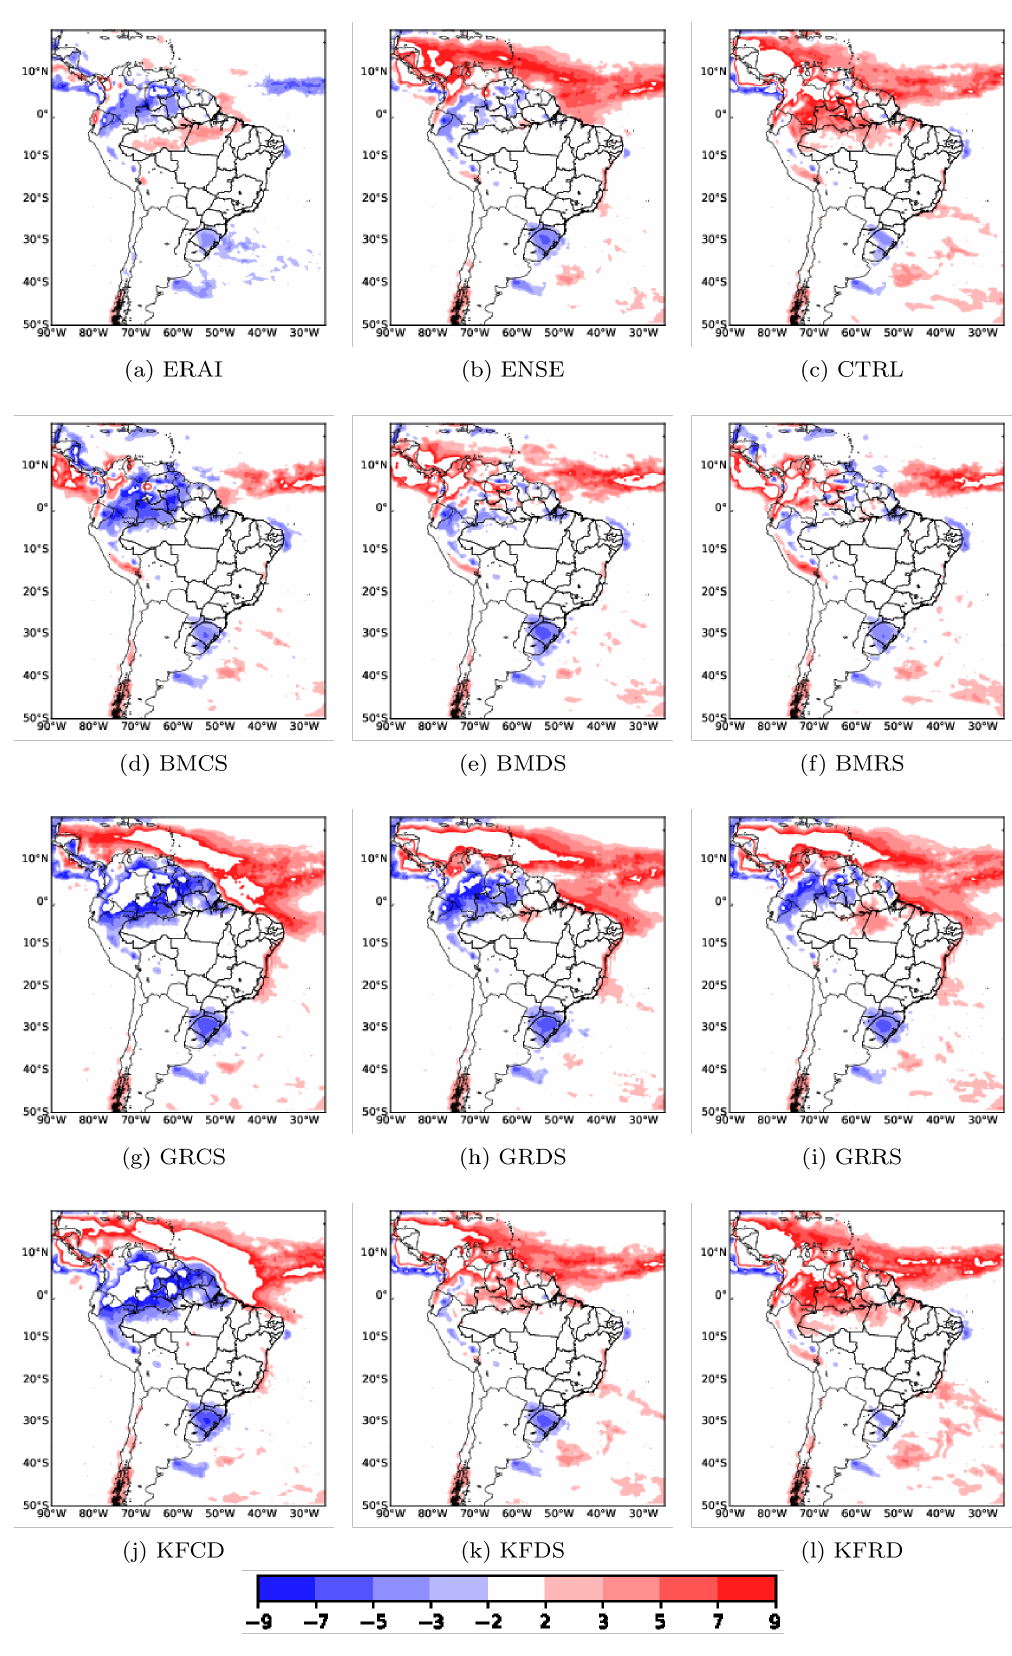
Figure 9. As in Figure 7, but for June–July–August